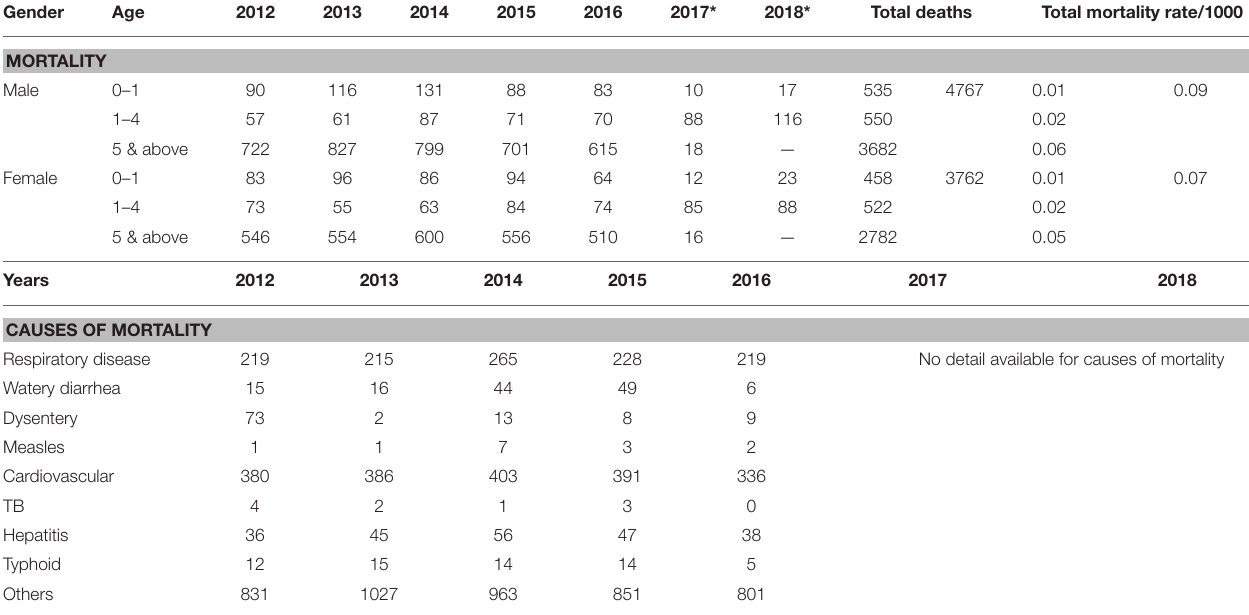
TABLE 1 | Mortality and causes of mortality in Afghan refugees.